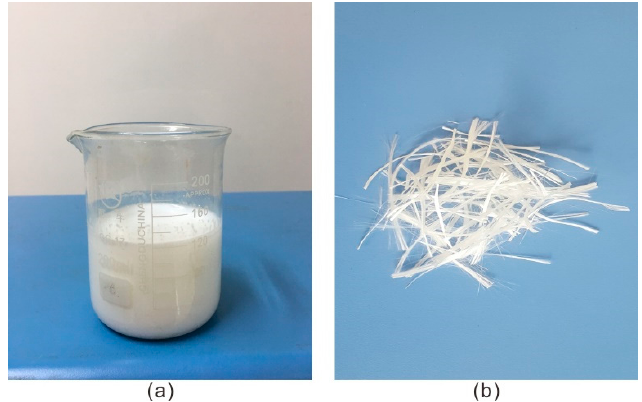
Figure 2. The material: ( a ) Water-based organic polymer; ( b ) Fiber glass.